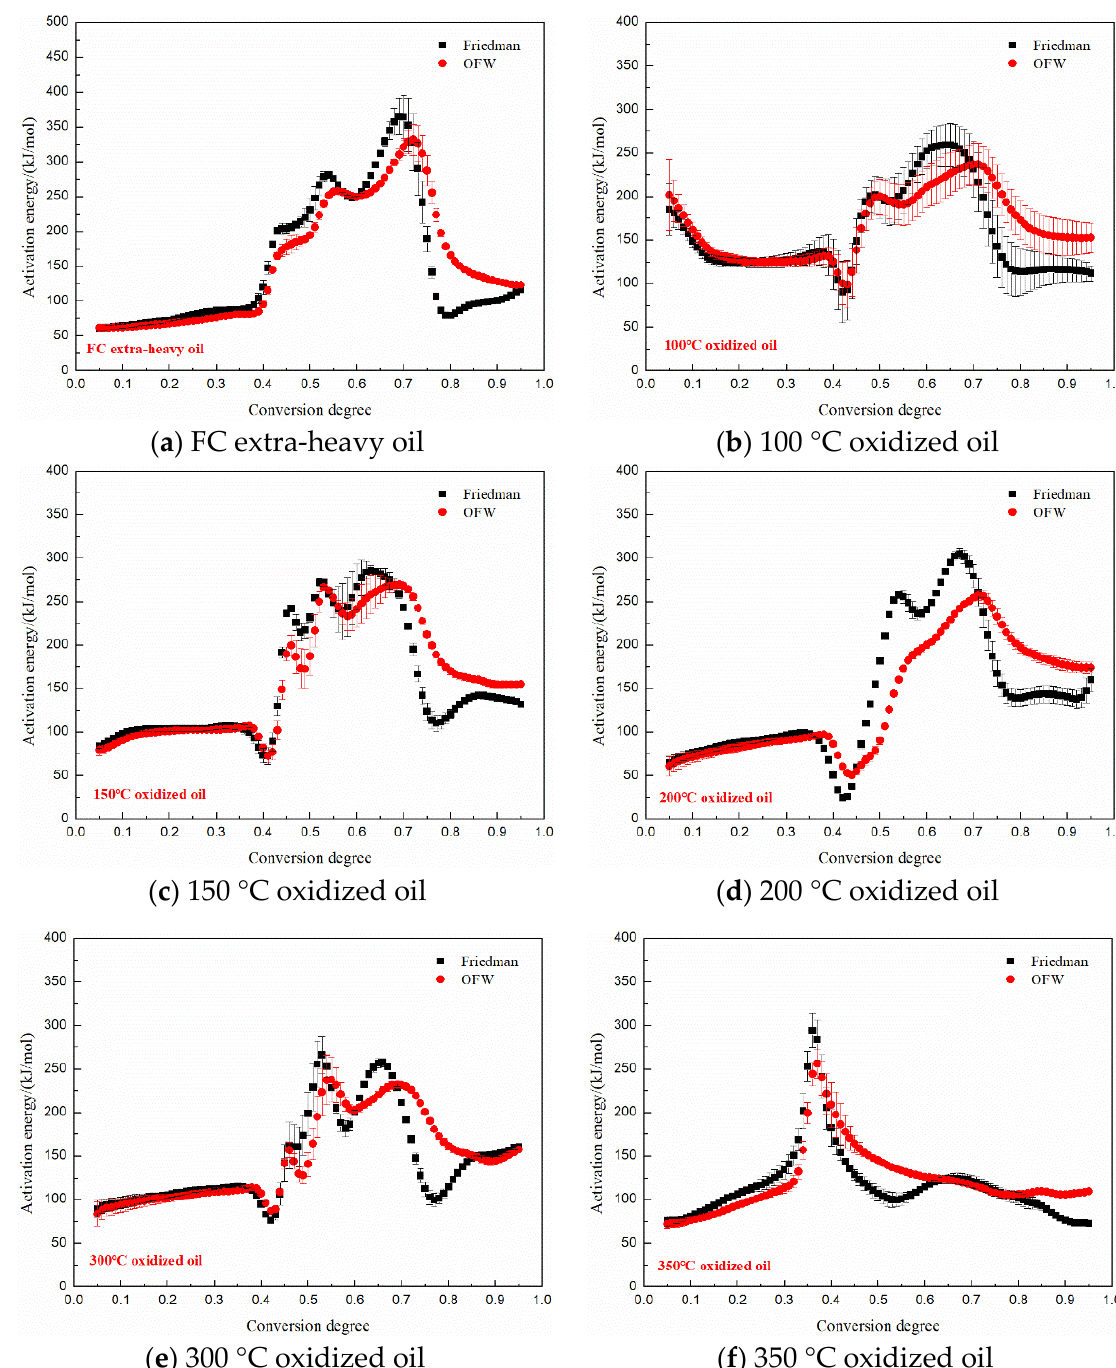
Figure 9. Activation energy versus conversion degree obtained by the Friedman and OFW methods for the FC extra-heavy oil and oxidized oils.